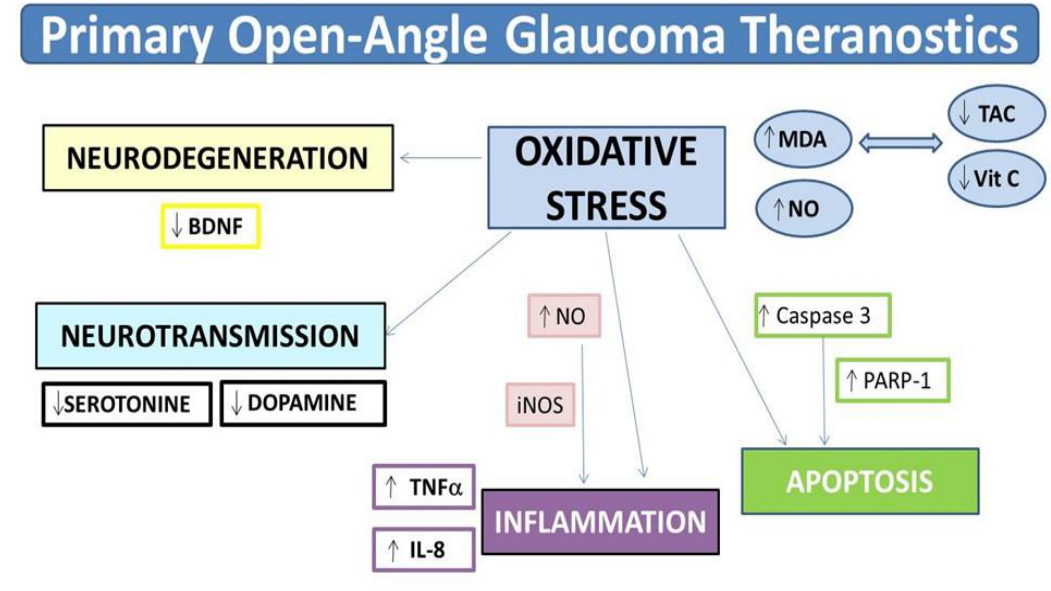
Figure 7. New diagnostic players and potential new therapies as primary-open-angle glaucoma theranostics. Excessive ROS generation / accumulation (superoxide anion (O2-), hydrogen peroxide (H 2 O 2 ), and hydroxyl radical (OH)) selectively damage the lipids, proteins, and nucleic acids. MDA is an important lipid peroxidation byproduct. Elevated levels of pro-oxidants and decreased antioxidant activity spreads the oxidative injury. OS can induce activation of transcription factors, leading to gene expression involved in inflammation. In fact, OS stress activates the iNOS, a pivotal element of the transcription factor NF-kB pathway that controls the pro-inflammatory response by releasing among others the TNF α and IL-8, both significantly augmented in POAG. Serotonin and dopamine are really prone to autooxidation, and its toxic metabolites may contribute to increase neurodegeneration. Lower plasma levels of these neurotransmitters have been found in POAG. Glaucoma neurodegeneration is the result of the apoptotic death of the RGC. Lower levels of BDNF have also been identified in our POAG biosamples. ROS: reactive oxygen species; MDA: malondialdehyde; OS: oxidative stress; iNOS: inducible nitric oxide synthase; NF-κB: nuclear factor